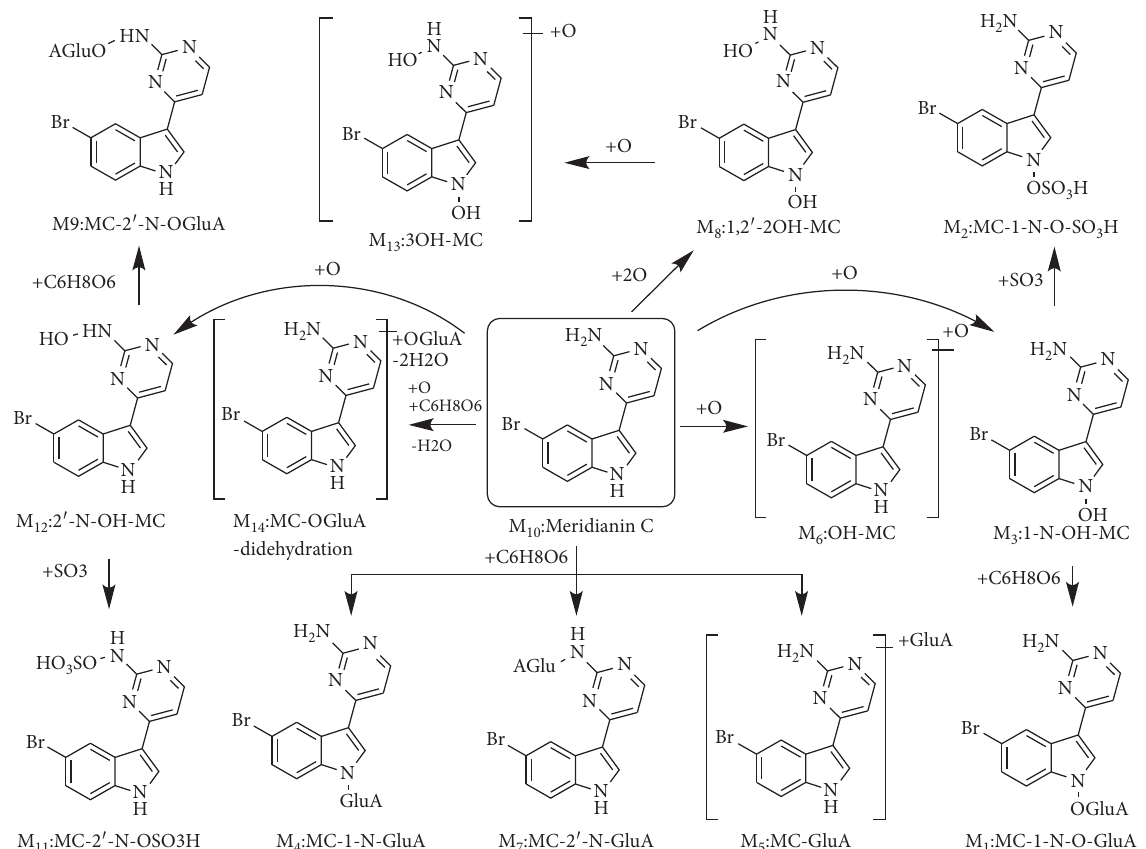
Figure 7: The proposed metabolic pathways of meridianin C in vivo of